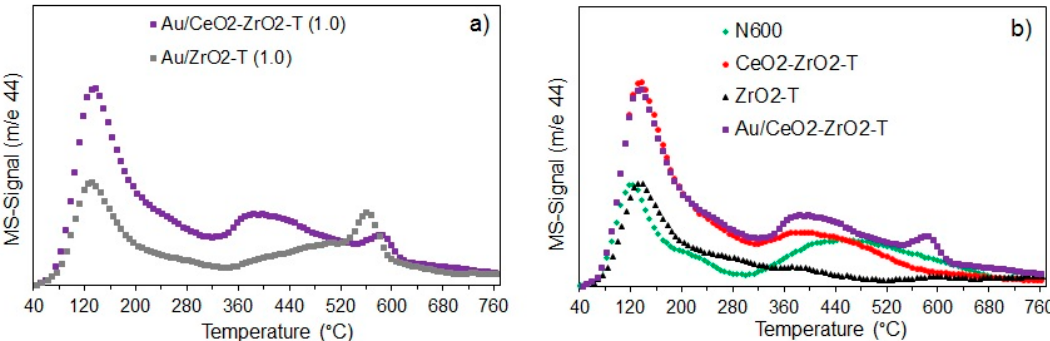
Figure 4. CO 2 -TPD profiles of Au-supported catalysts ( a ) and supports ( b ) activated ex-situ at 300 °C in 100 mL/min H 2 .